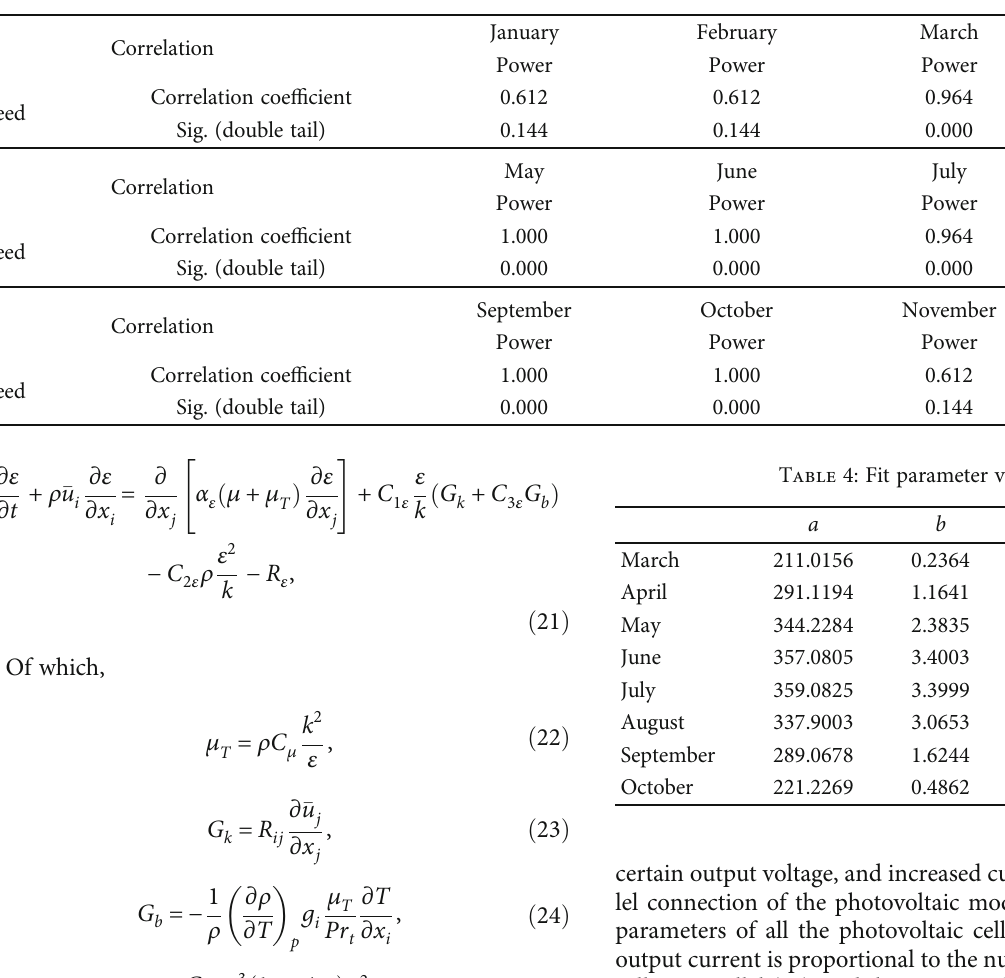
Table 3: Correlations for P-v from January to December.